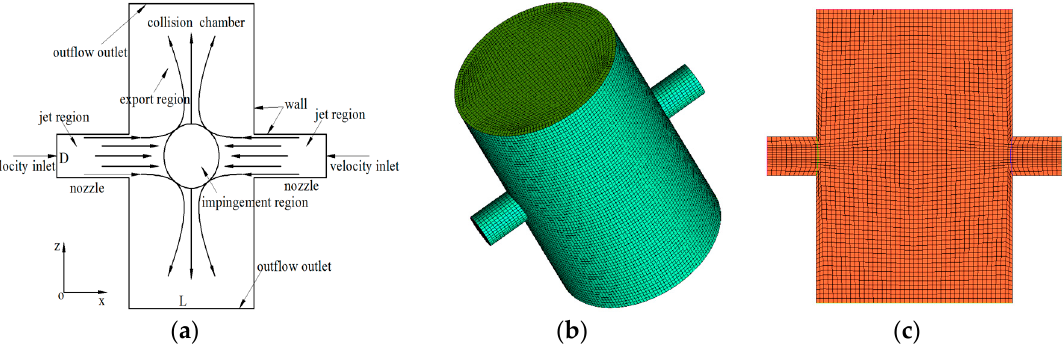
Figure 2. Geometric model of an impinging stream reactor. ( a ) x z plane; ( b ) physical map; ( c ) x z plane mesh model.